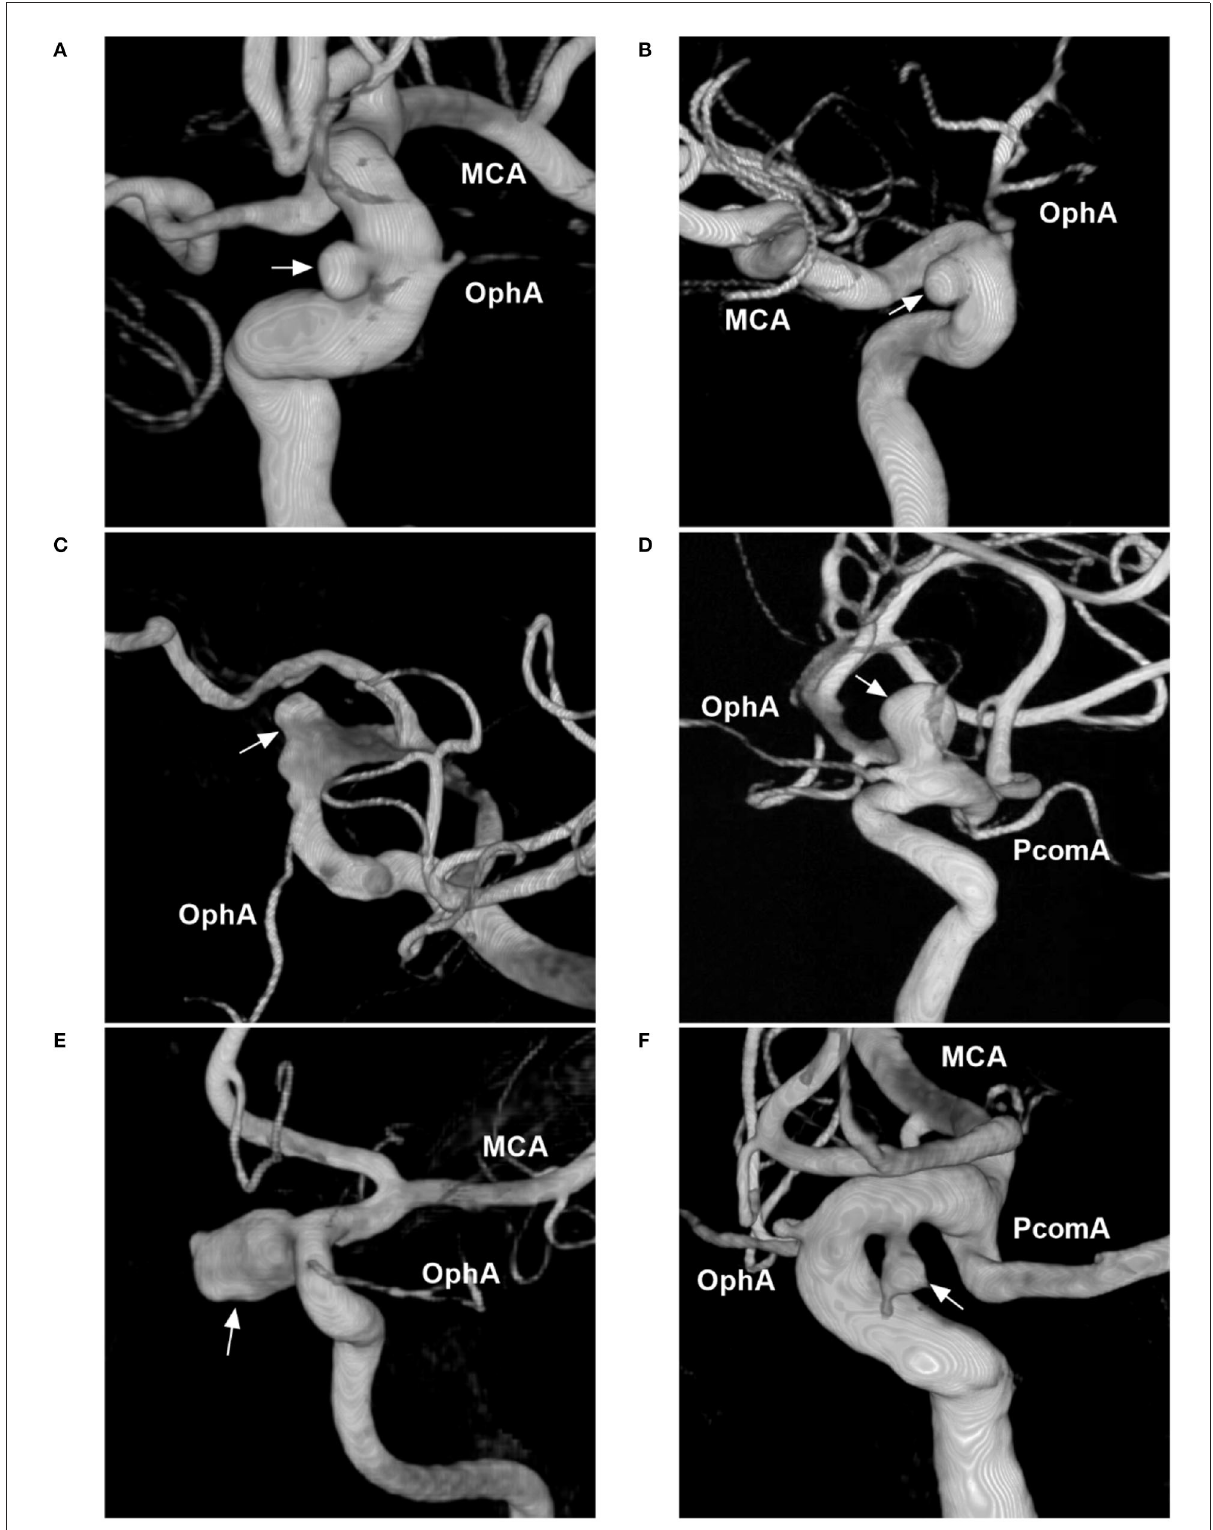
FIGURE2 Classification of aneurysms of the paraophthalmic segment according to their locations. (A) Three-dimensional DSA shows a carotid cave aneurysm (arrow). (B) Three-dimensional DSA shows a clinoidal aneurysm (arrow) opposite the carotid cave. (C) Three-dimensional DSA shows an OphA aneurysm (arrow); the OphA was located away from the aneurysm neck. (D) Three-dimensional DSA shows an OphA aneurysm